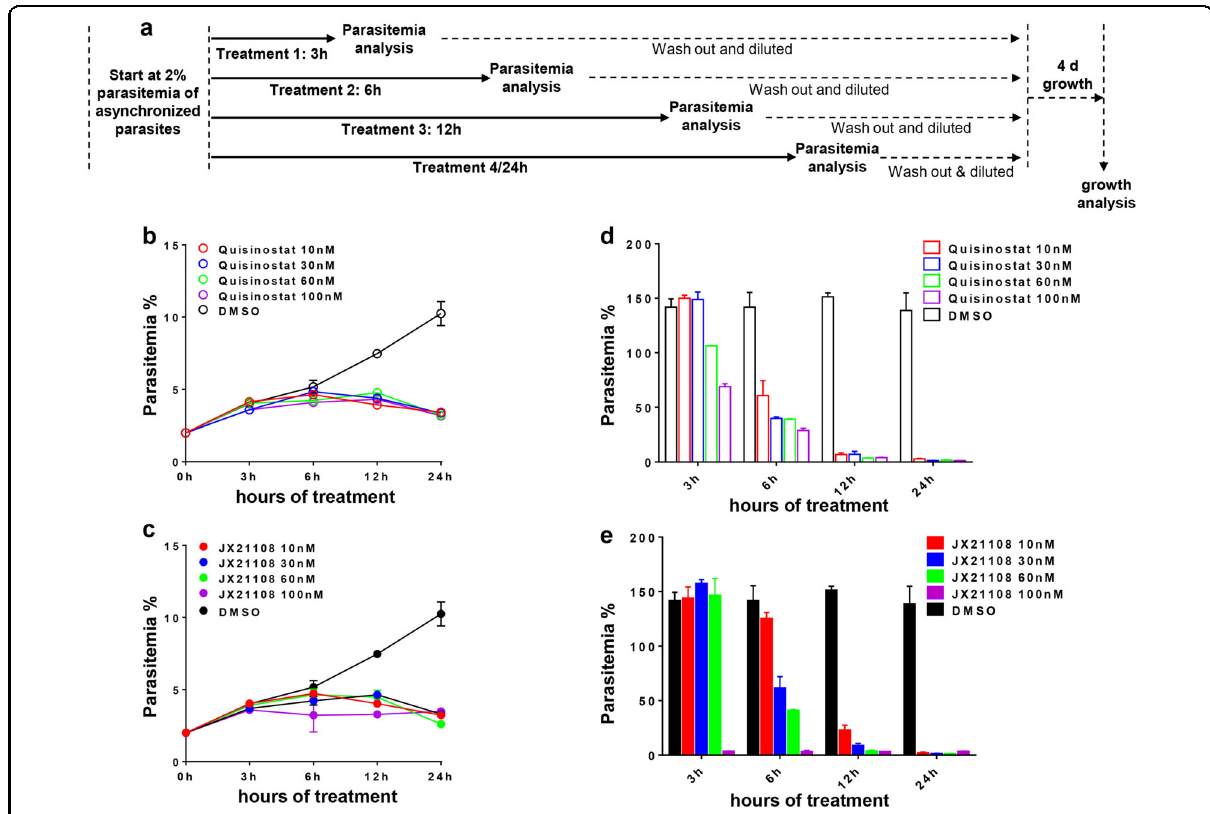
Fig. 4 Time- and dose-dependent antiplasmodial activity of JX21108. a Schematics of the experimental design. Asynchronous 3D7 parasites were exposed to the tested compounds at the given concentrations for different time periods, as shown. b , c Parasites were exposed to the indicated concentrations of quisinostat ( b ) and JX21108 ( c ) for 3, 6, 12 or 24 h. Parasitemia was detected immediately after treatment by fl ow cytometry. d , e The treated parasites from b and c were washed, followed by 1:40 dilution and cultured for 4 days. Parasitemia was measured by fl ow cytometry. Data are means ± SEM of 100,000 RBCs from three biological